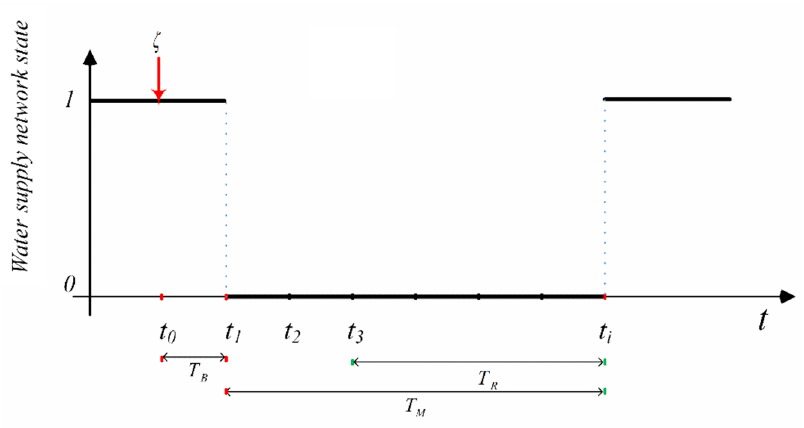
Figure 7. Performance dynamics of the example water supply network after a large flood.